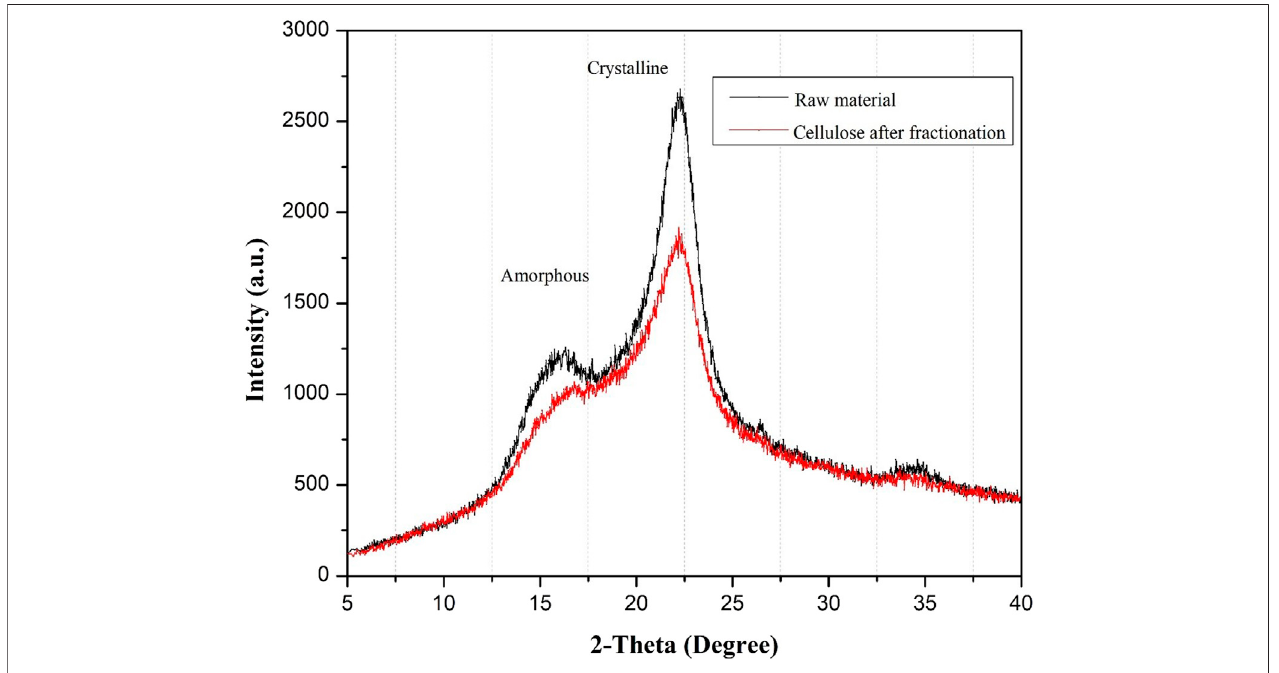
FIGURE 3 | X-ray diffraction patterns of solid residue.